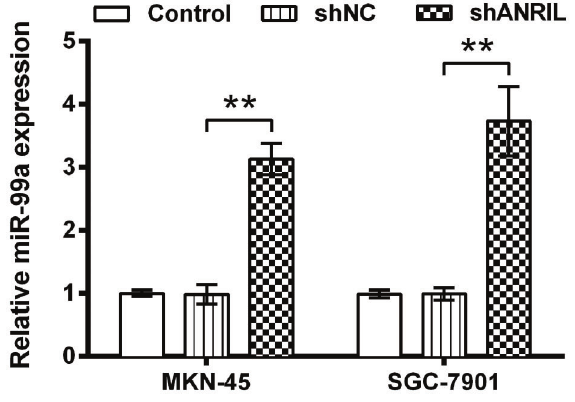
Figure 3. Knockdown of antisense non-coding RNA in the INK4 locus (ANRIL) up-regulated miR-99a expression. Untreated cells acted as control. The expression level of miR-99a was measured by qPCR. U6 acted as an internal control. shANRIL: pENTRTM/ U6 vector carrying small hairpin RNA targeting ANRIL; shNC: pENTRTM/U6 vector carrying a non-targeting sequence; qPCR, quantitative real-time PCR; miR-99a, microRNA-99a; Data are reported as means ± SD.**P o 0.01 (two-tailed Student ’ s t